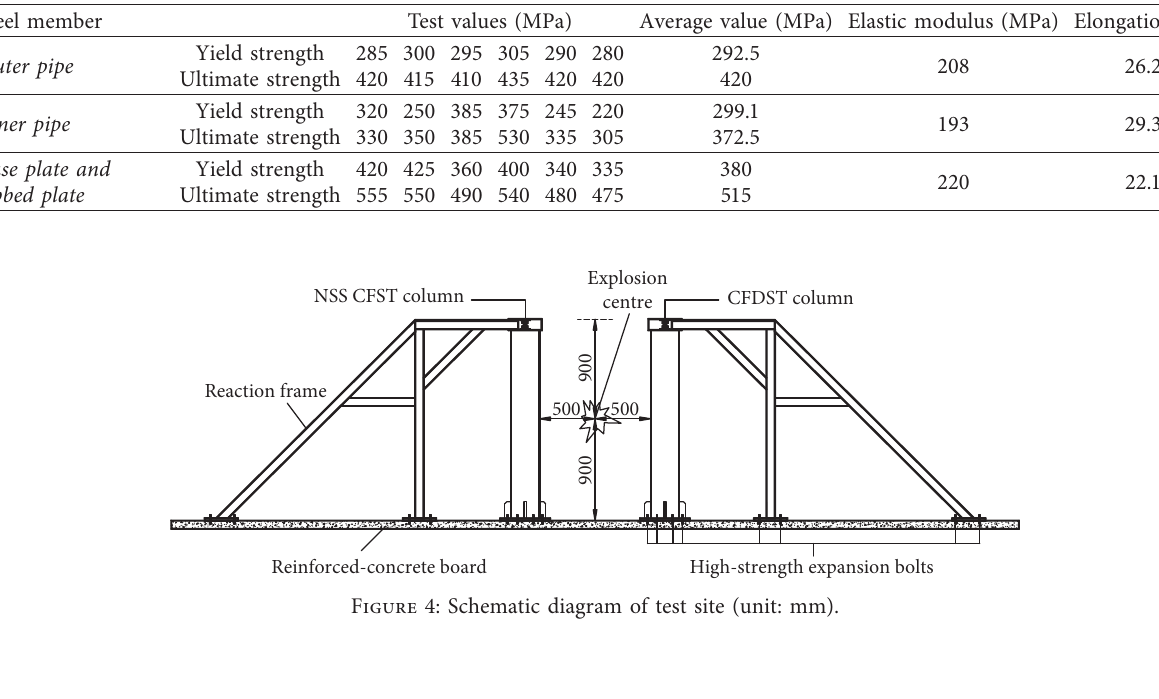
Table 2: Steel properties.